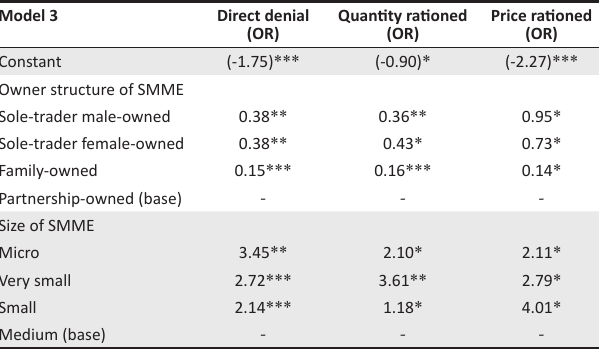
TABLE 3: Small, micro and medium enterprise structural effects on type of credit rationing of small, micro and medium enterprises. Model 3